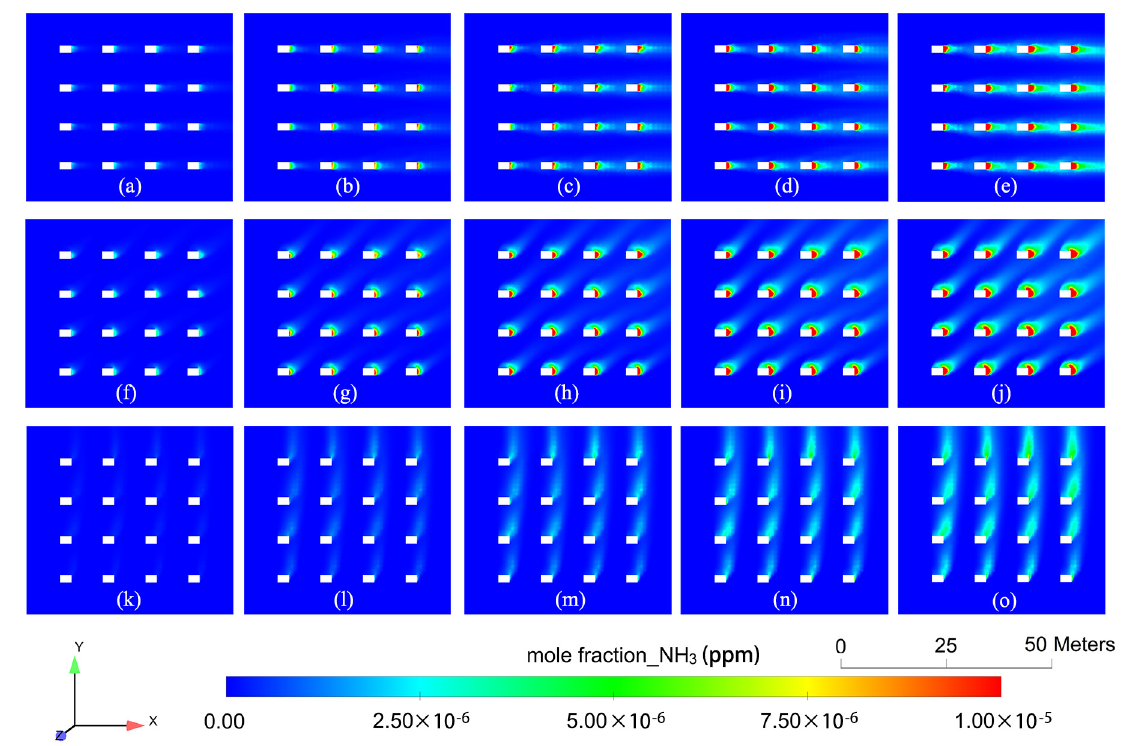
Figure 8. Ammonia mole fraction at 1.5 m above the ground in scenarios with 8 m intervals, in which the wind direction and outlet emission intensity are: ( a ) 0° and 10 ppm; ( b ) 0° and 30 ppm; ( c ) 0° and 50 ppm; ( d ) 0° and 70 ppm; ( e ) 0° and 90 ppm; ( f ) 45° and 10 ppm; ( g ) 45° and 30 ppm; ( h ) 45° and 50 ppm; ( i ) 45° and 70 ppm; ( j ) 45° and 90 ppm; ( k ) 90° and 10 ppm; ( l ) 90° and 30 ppm; ( m ) 90° and 50 ppm; ( n ) 90° and 70 ppm; ( o ) 90° and 90 ppm.